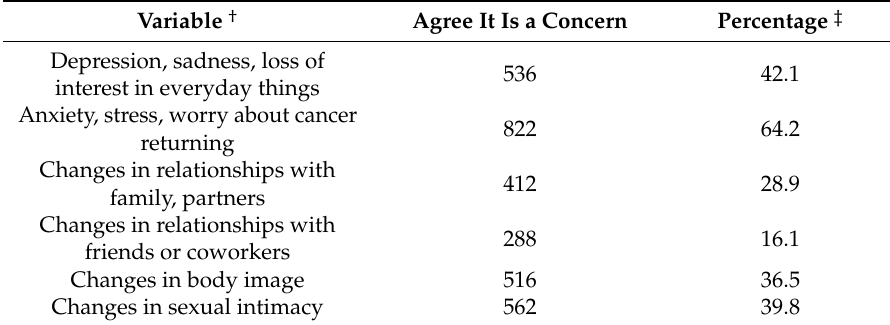
Table 3. Respondents’ agreement with psychosocial